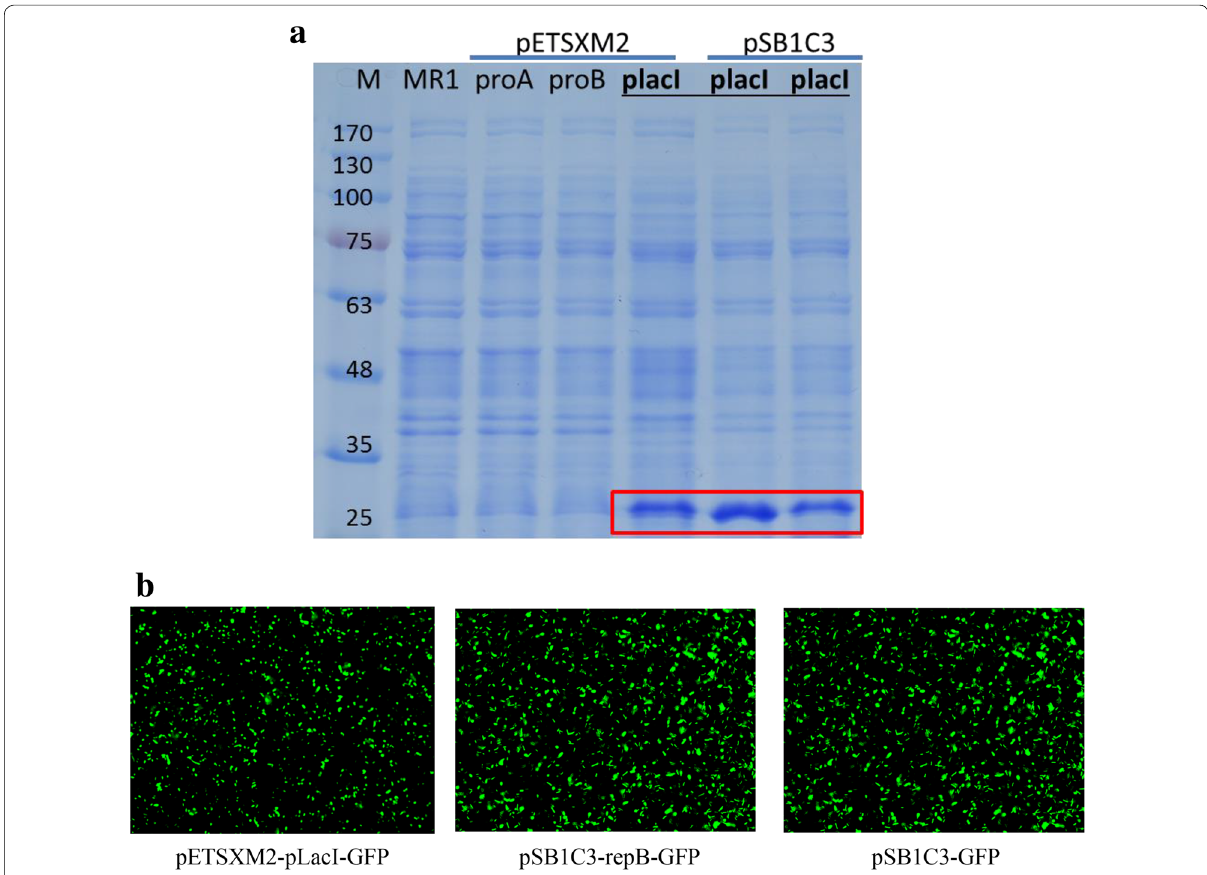
Fig. 2 a SDS‑PAGE analysis of over‑expression of GFP in S. oneidensis MR‑1. Lanes from left to right: Marker, MR‑1 wild type, pETSXM2‑proA, pETSXM2‑proB, pETSXM2‑pLacI, pSB1C3‑repB‑pLacI and pSB1C3‑pLacI. b Cell pictures in 465–495 nm. From left to right are pETSXM2‑pLacI‑GFP, pSB1C3‑repB‑GFP and pSB1C3‑GFP,